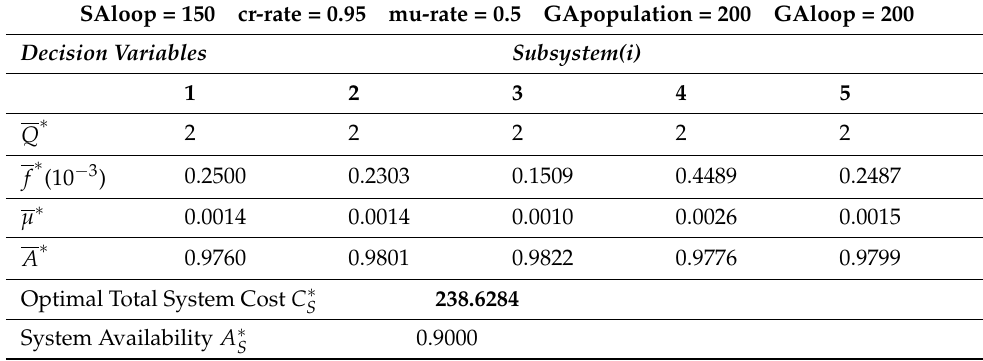
Table 32. Optimal Solutions obtained by NESA–MGA for the for the n -stage q /2-out-of- q system. SAloop = 150 cr-rate = 0.95 mu-rate = 0.5 GApopulation = 200 GAloop = 200